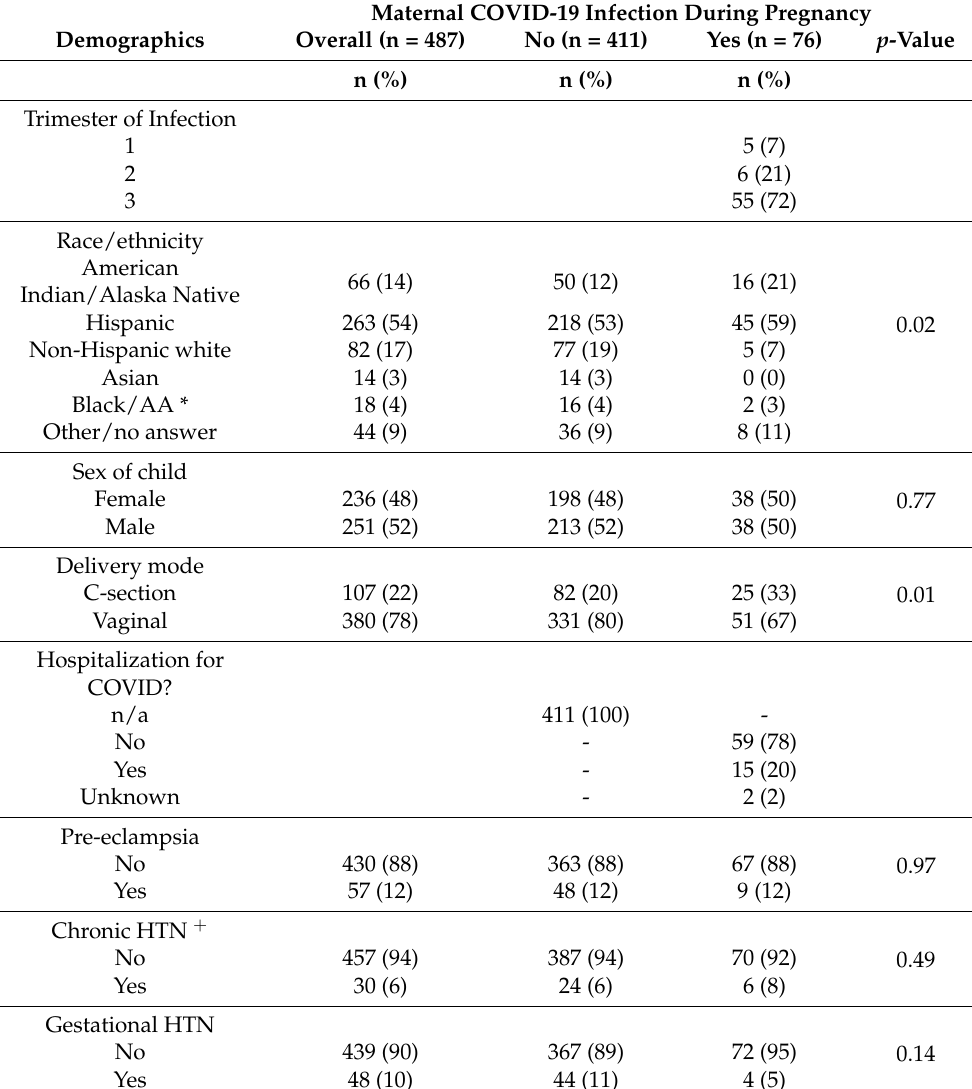
Table 2. Maternal demographics of CovNeg and CovPos groups.